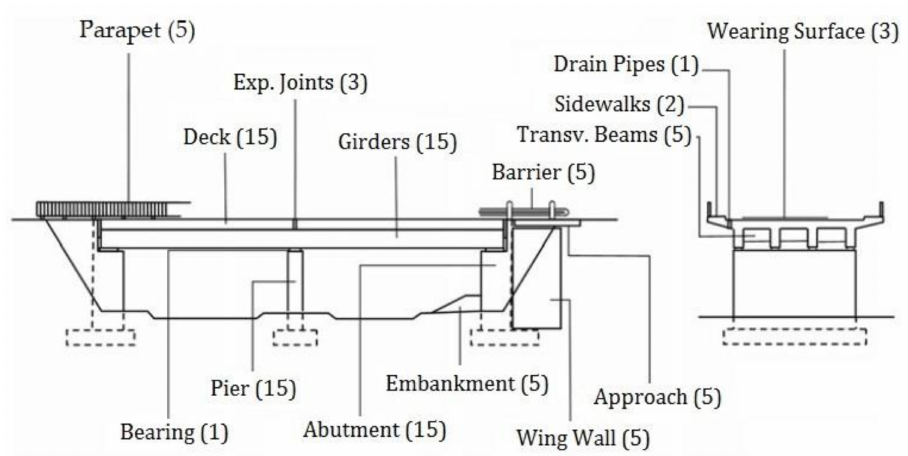
Figure 2. Weight importance of elements for a conventional concrete